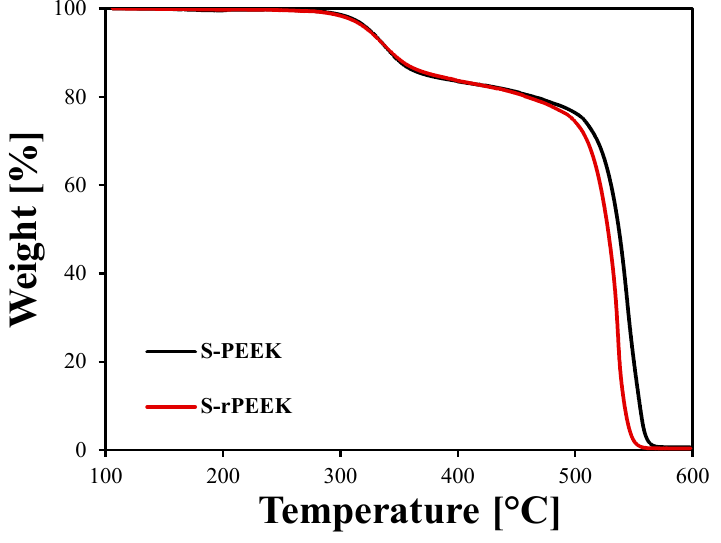
Figure 1. Thermo-gravimetric plot of weight vs. temperature of S-PEEK and S-rPEEK polymer in the range 100–600 °C.